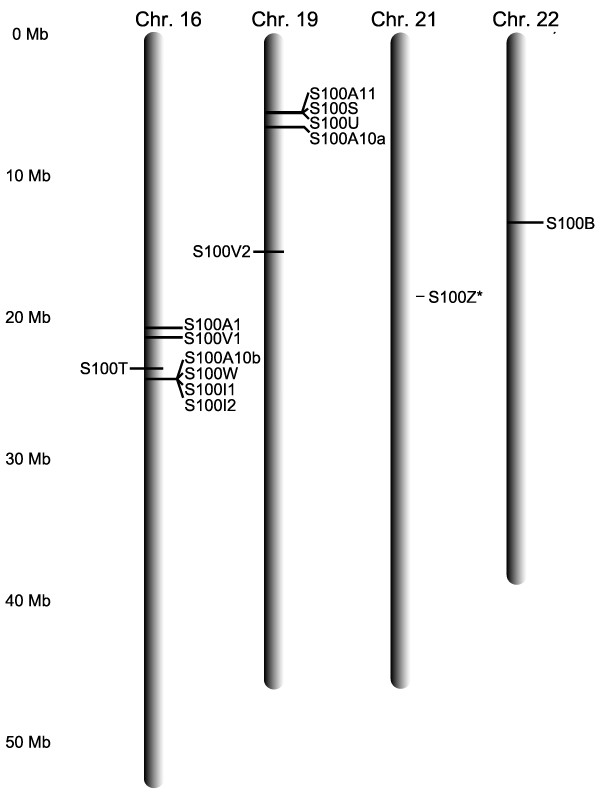
Chromosomal location of the s100 genes in zebrafish. Genes are distributed in two clusters and three singletons on four different chromosomes. Vertical scale, distance in Mb. Orientation of the genes is indicated by left/right position (reverse/forward strand, respectively). Genomic location was retrieved from the Ensembl database, release 47, based on assembly zv7, April 2007 [50], see also Additional File 2). The genomic location of s100z is currently unclear.